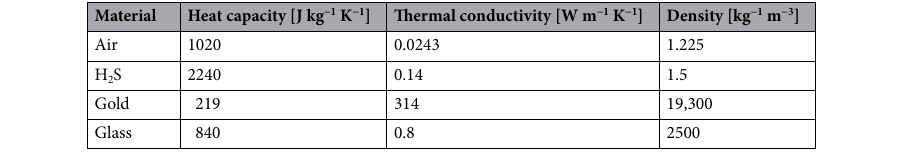
Table 1. Materials’ properties used in Eq.